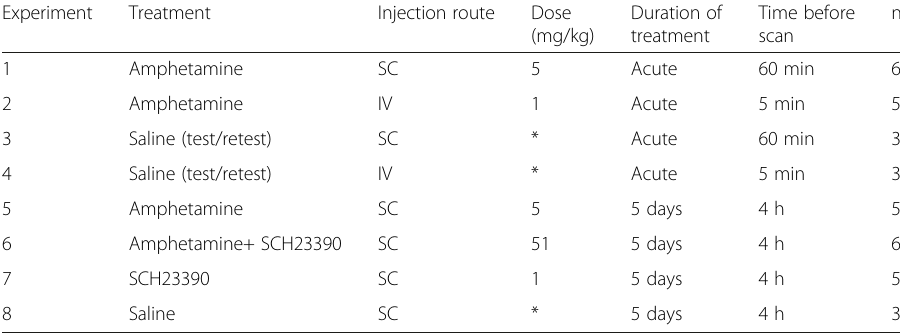
Table 1 Overview of the different treatment groups (* saline treatment, equivalent volumes) Experiment